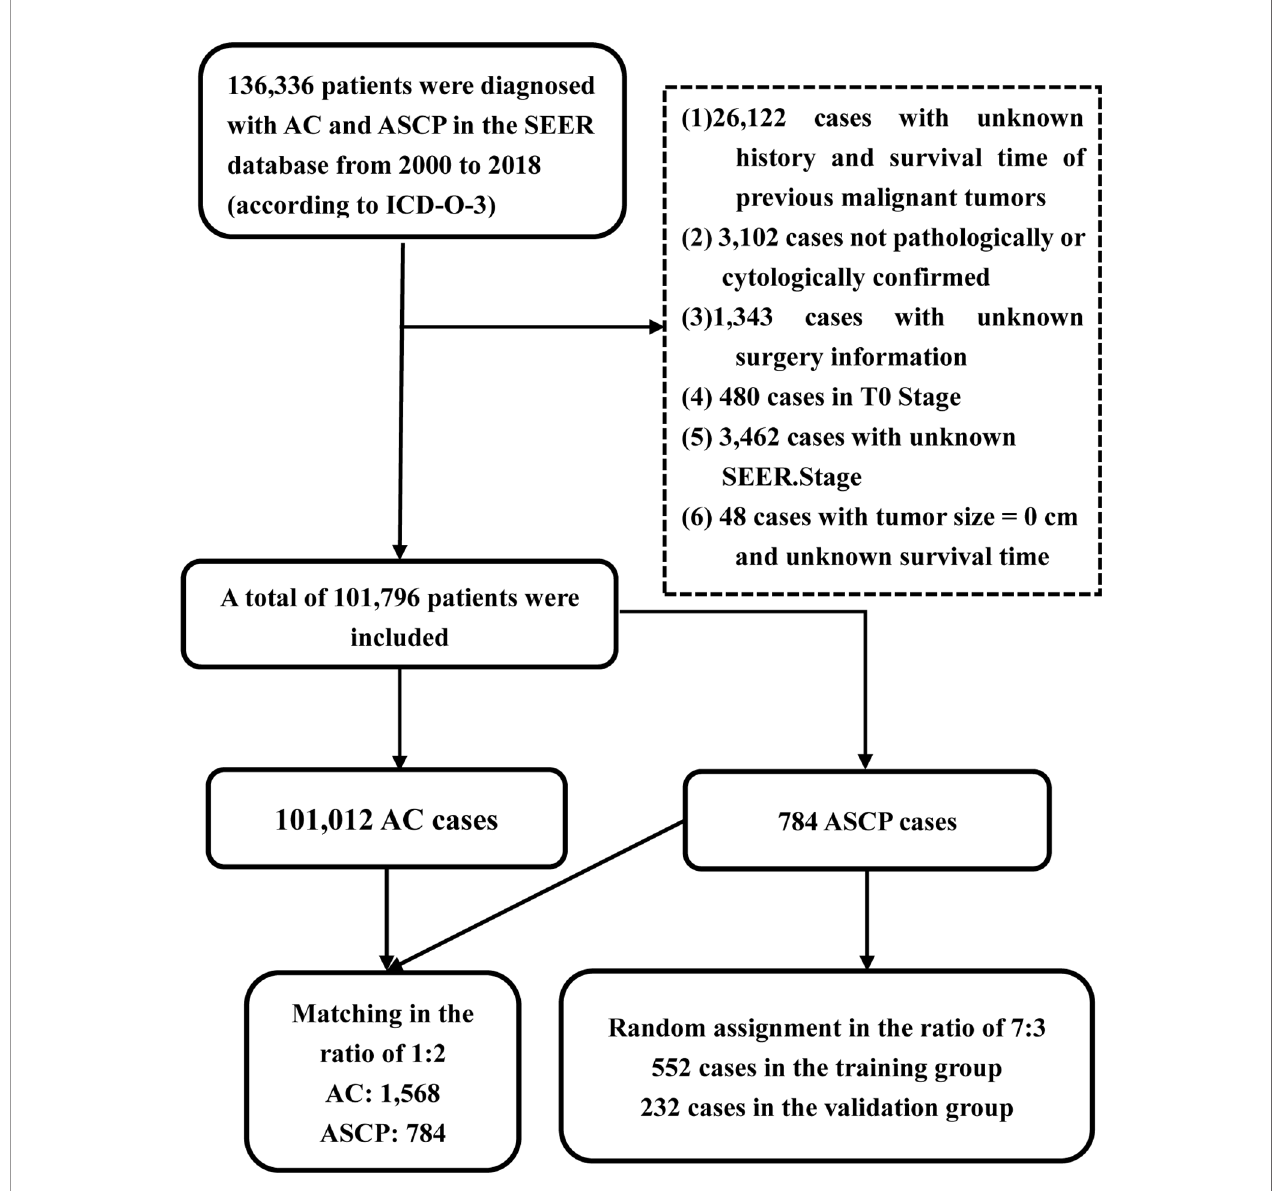
FIGURE 2 | Flowchart for Selecting Patients from SEER